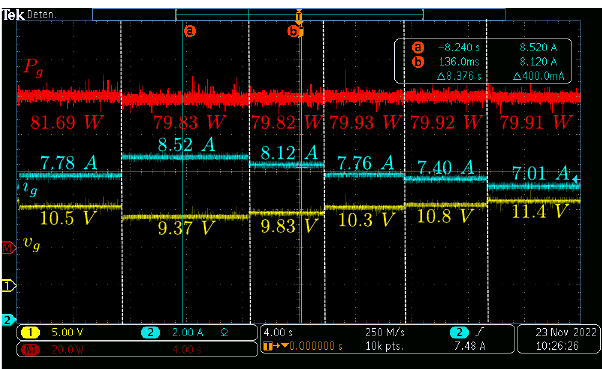
Figure 10. Performance of the current controller with reference changes.